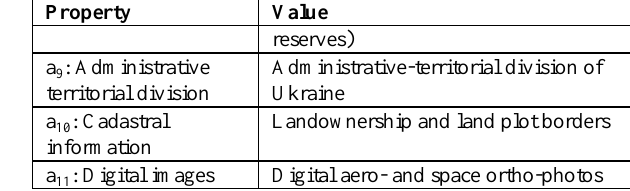
Table 1. Values of properties a i . (TMC) means that the property is determined according to the column «Classification group» of TopoMaps Classifier, used in Ukraine Backdrop Value b 1 : Time Time period during which the base map of Ukraine exists. Similar record is t. b 2,3 : Surface Combination of Earth surfaces within the borders of Ukraine in different periods of its existence. Similar record is (x, y). Table 2. Values of backdrops b j Specific image